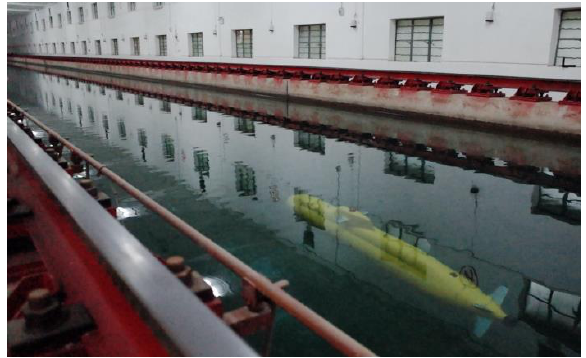
Figure 13 . The xAUV is sailing in the towing tank. Figure 13. The xAUV is sailing in the towing tank.